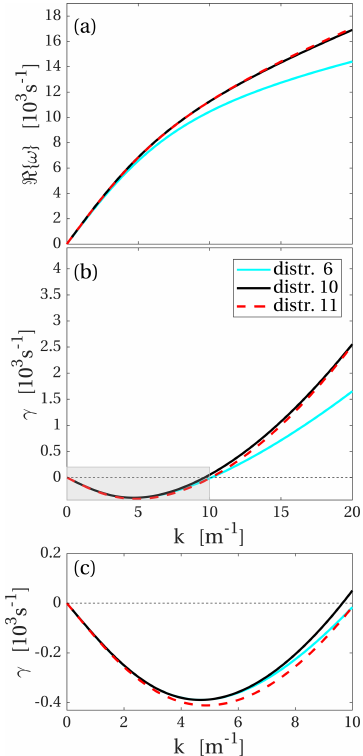
Figure B1. Dispersion relations for distributions with different suprathermal tails. Distribution 6 is the same as the distribution with that number shown in Fig. 6, and it has m = 3 for the ions and m = 5 for each of the two electron populations. Distribution 10 has m = 6 and distribution 11 m = 8 for all three populations. (a) Real part of the dispersion relation. (b) Damping rate γ . (c) Close-up of the shaded rectangle in (b) . Positive values of γ correspond to wave damping and negative values to wave